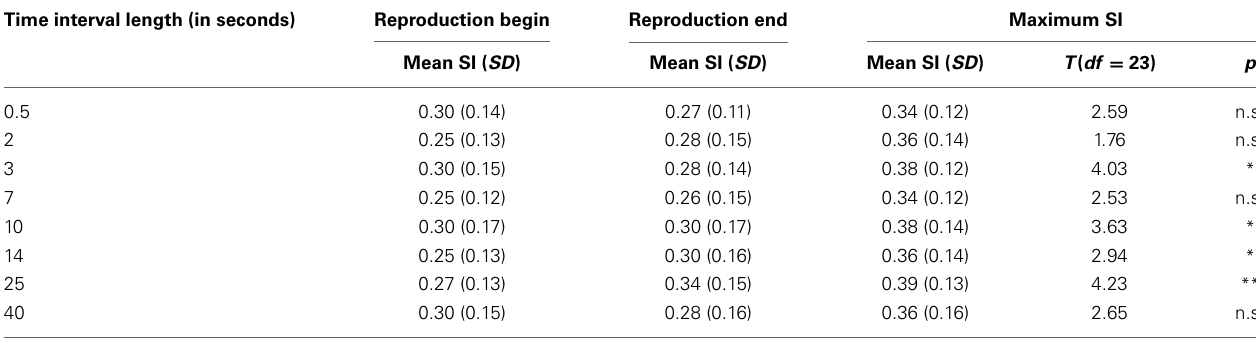
Table 2 | Statistical analysis of the synchronization indices for the different time intervals. Time interval length (in seconds)